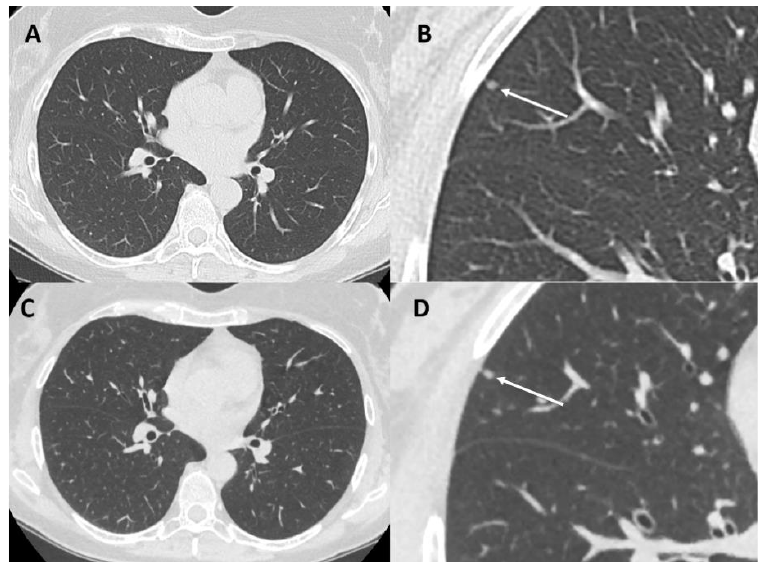
Figure 1. Chest computed tomography (CT) of a 36-year-old woman with osteosarcoma at baseline (panel ( A , B )) with standard protocol (DLP = 248 mGy/cm) and at two-month follow-up (panel ( C , D )) with full IR model-based (MBIR) algorithm (VEO) protocol (DLP = 45 mGy/cm) both well demonstrate a small solid nodule (arrows-diameter 2 mm). DLP = dose length product .